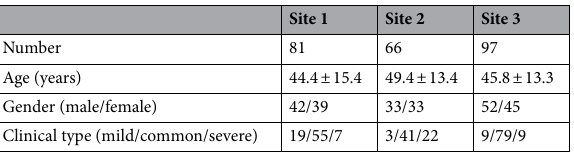
Table 1. The demographic and clinical information of the multi-center database of